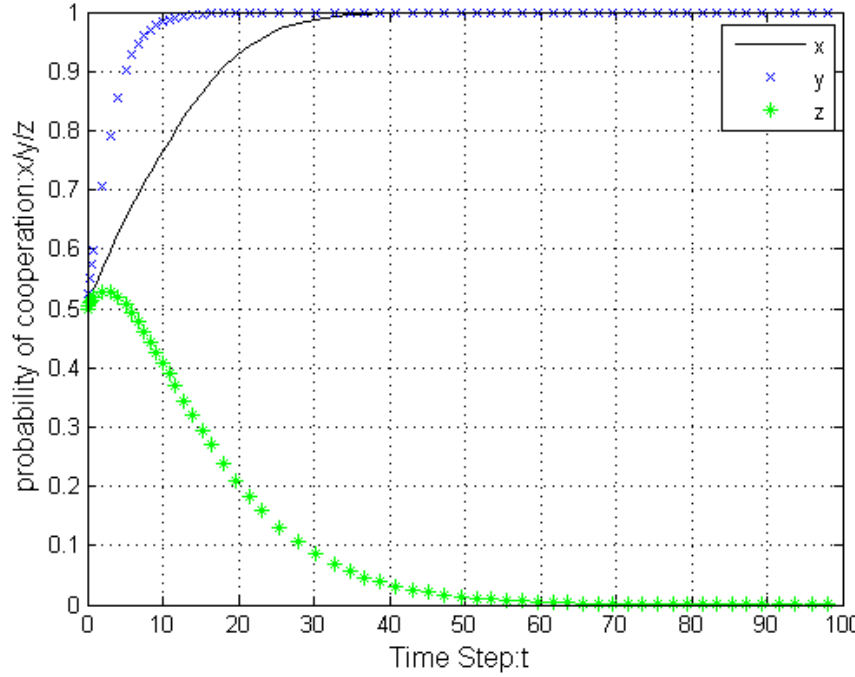
Figure 9. Evolution simulation, Scenario 9.